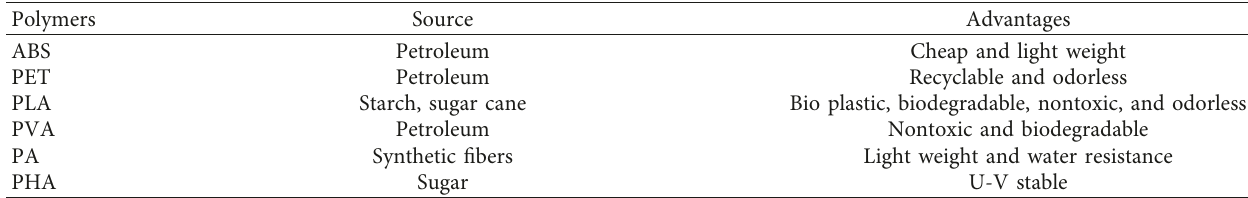
Figure 1: Classification of polymers [45]. Table 4: List of commonly used polymers as filaments in FDM